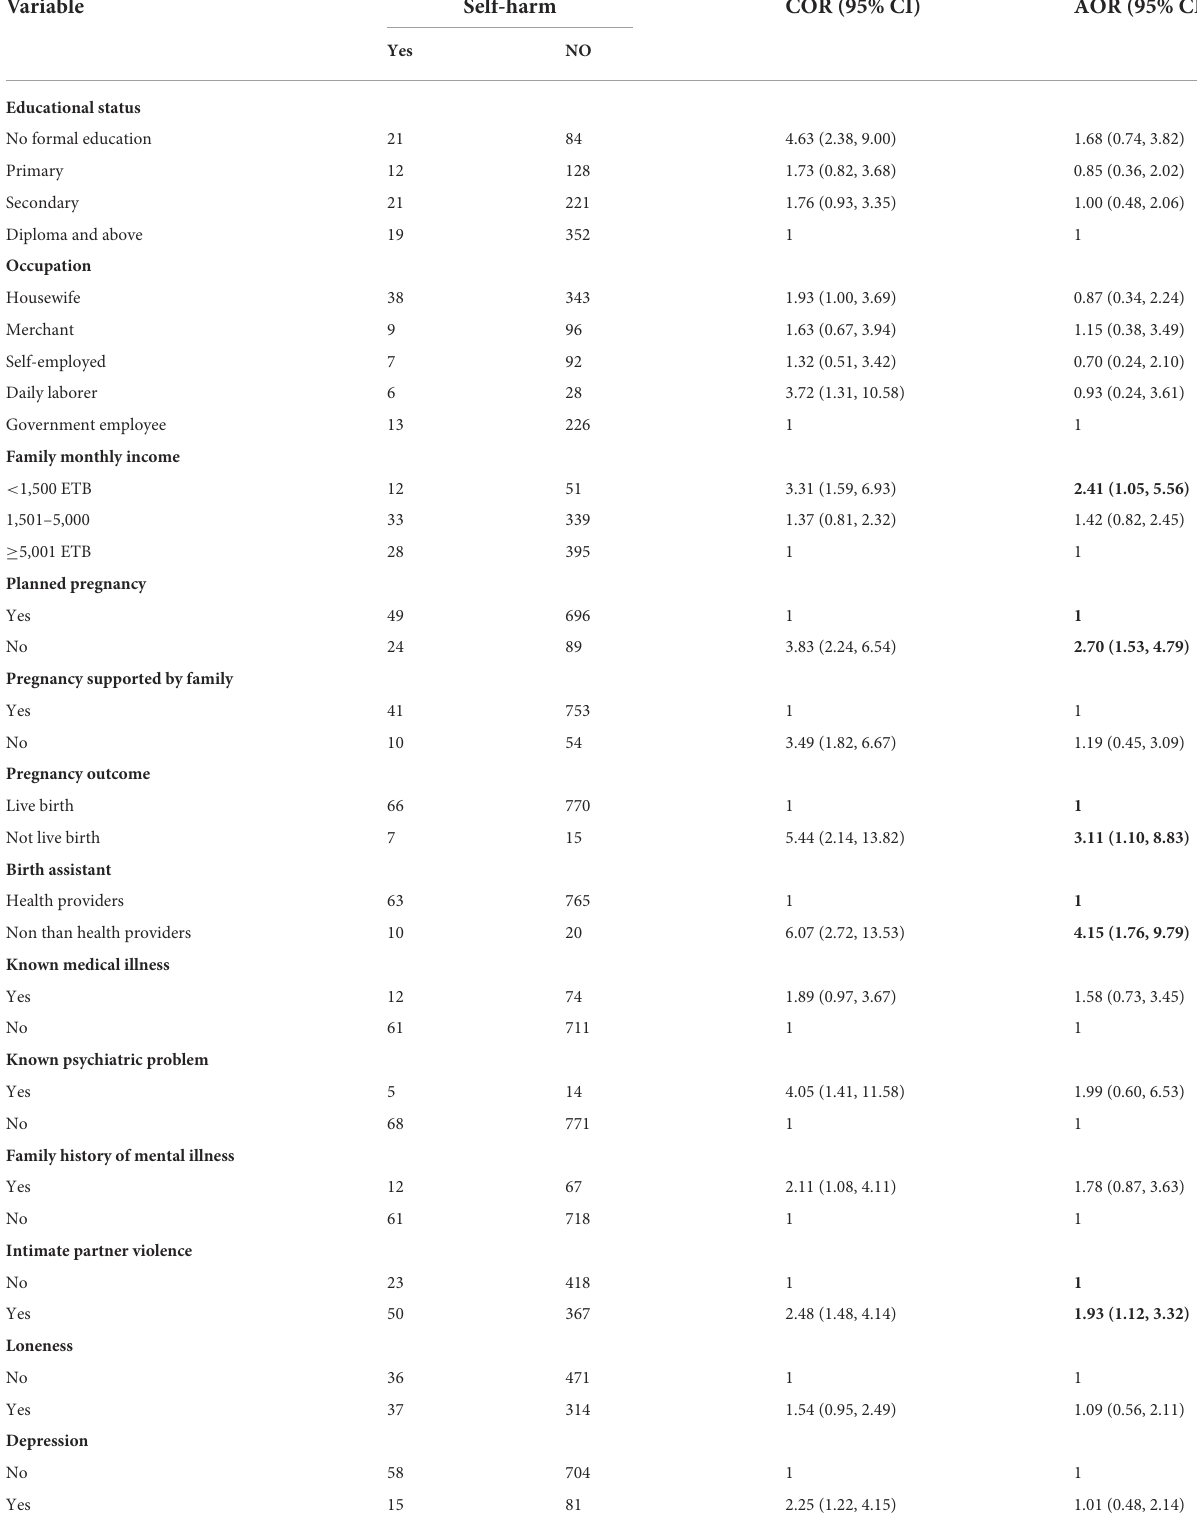
TABLE 3 Bi-variable and multivariable logistic regression analysis of postnatal self-harm and associated factors in Gondar City, Northwest Ethiopia, 2021, ( n = 858).